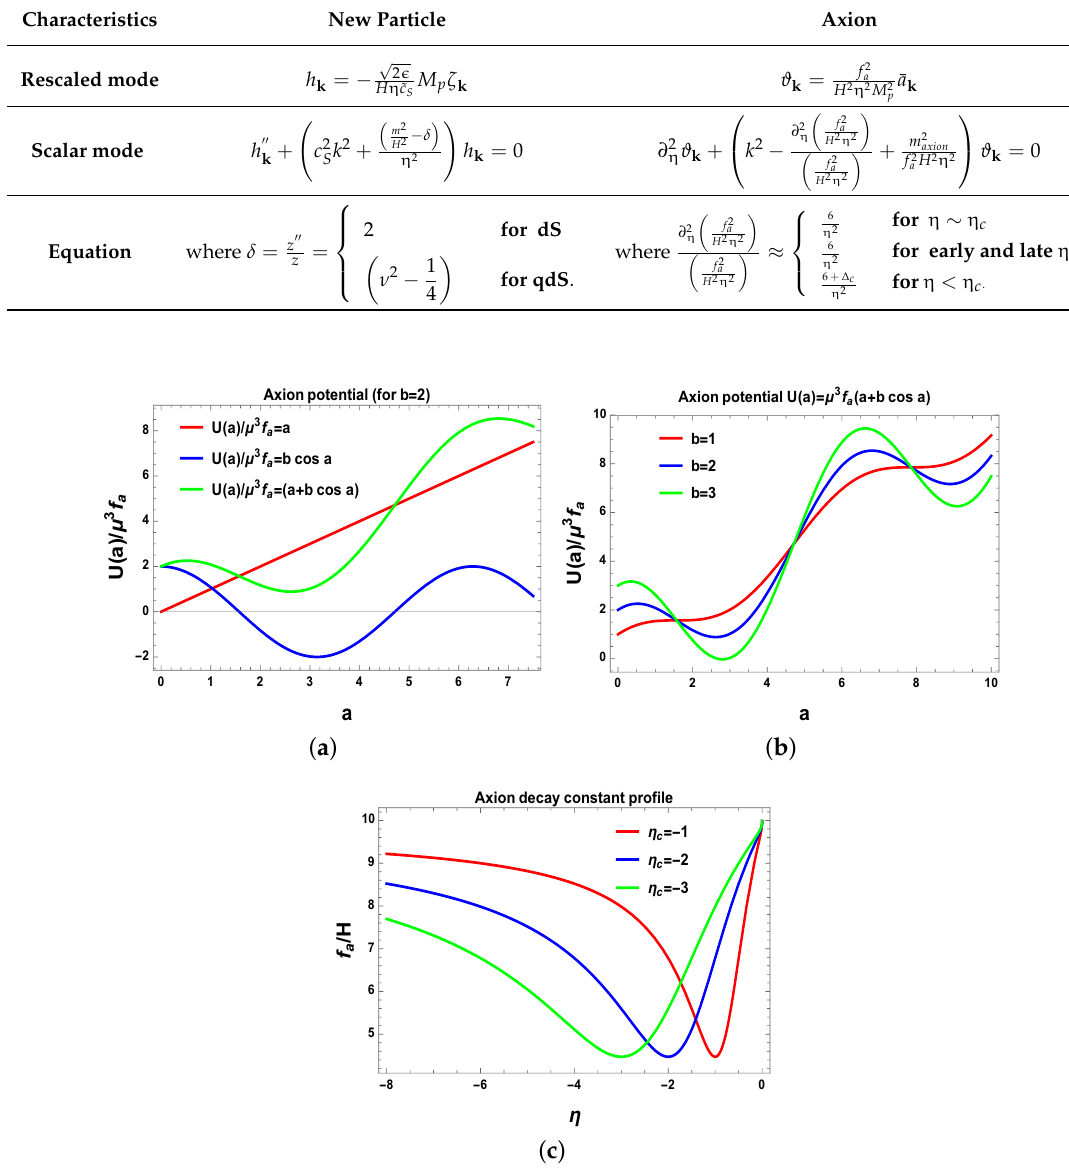
Figure 5. Behaviour of the axion effective potential and time-dependent decay constant. ( a ) Various parts of potential; ( b ) Total potential; ( c ) Axion decay constant profile. Here pictures are taken from